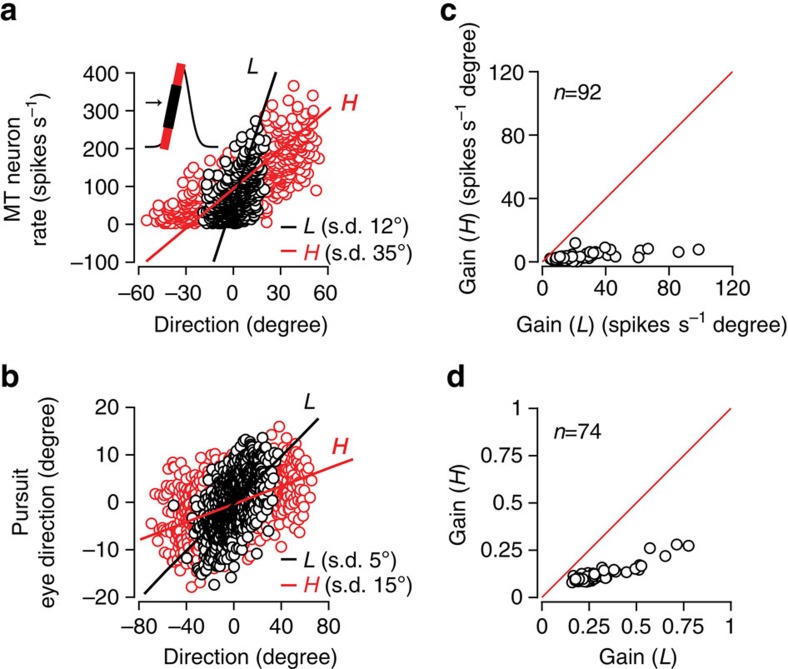
Gain rescales with stimulus variance in MT neurons and pursuit.(a) A single MT unit's input output function for a low-variance (L, s.d. 12°, black circles) and high-variance (s.d. 35°, red circles) motion stimulus. Circles represent mean values in 20 ms windows. Direction fluctuations measured with respect to the mean (black arrow, inset). Black, red lines correspond to the dominant mode of variation in the data and represent the best estimate of the response gain. (b) Eye movements from the same monkey: low variance (L, s.d. 5°, black circles) and high variance (H, s.d. 15°, red circles). (c) MT population data showing linear gain for L and H variance conditions in a (pop. mean L: 23±27; H: 3.0±2.1, significantly different, two-sided Wilcoxon rank-sum test, P<10−28, n=92). (d) Pursuit population data (pop. mean L: 0.28±0.13; H: 0.12±0.04, significantly different, two-sided Wilcoxon rank-sum test, P<10−22, n=74, 3 monkeys).